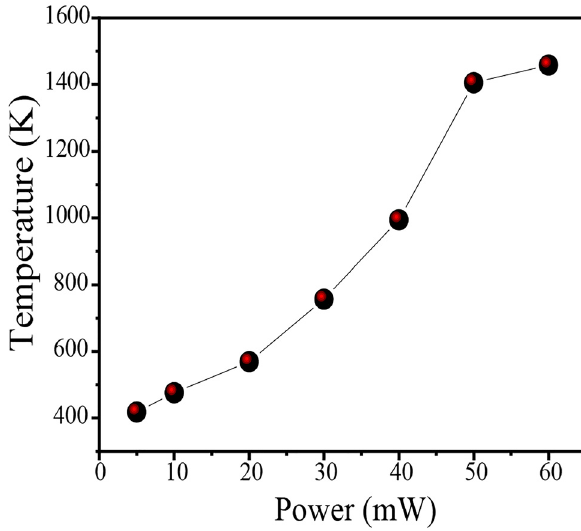
Figure 4: The power-dependent temperature at the optical heater, calculated from the FIR value ( I 523 / I 555 ).